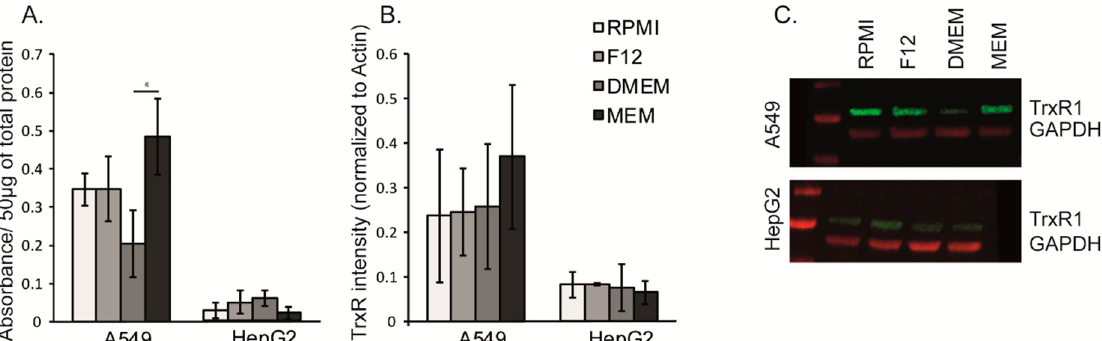
Figure 4. Activity and levels of TrxR. ( A ) Changes of TrxR activity influenced by cell culture media determined with TrxR-assay and ( B ) TrxR1 protein concentration analyzed by western blot. Quantification was made with three independent experiments. ( C ) Representative Western Blot image. Data is presented as mean +/ − standard deviation. Statistical analysis was performed by using the Kruskall-Wallis test (* p < 0.05).